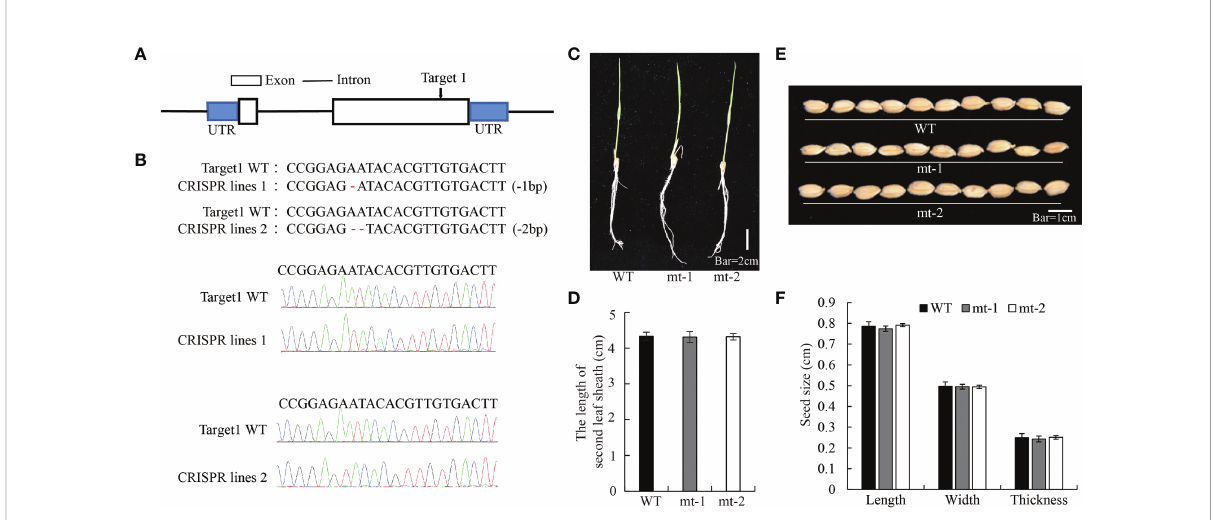
FIGURE 3 Development and morphology of OsDREB2B-mt rice. (A, B) Osdreb2b mutants were produced in rice using a cluster of regularly spaced short palindrome repeats (CRISPR)/CRISPR-associated protein 9 (Cas9) system. (C) Whole-plant morphology of the mt lines and the WT at the seedling stage. Bar = 2 cm. (D) The second leaf sheath length of OE lines and the WT. (E) Seed morphology. Bar = 1 cm. (F) Seed size of the OE lines and the